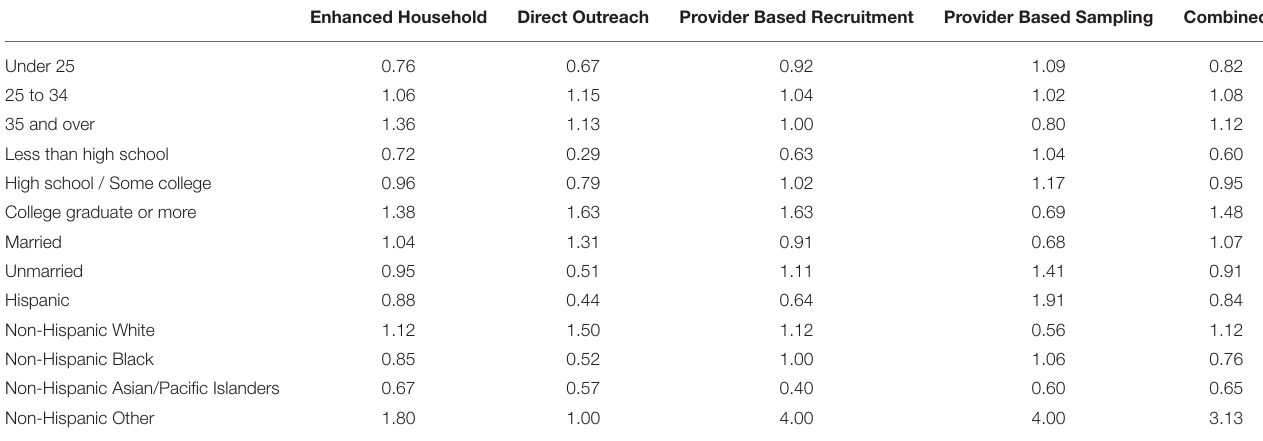
TABLE 2 | Demographics of NCS vanguard study. Enhanced Household Direct Outreach Provider Based Recruitment Provider Based Sampling Combined